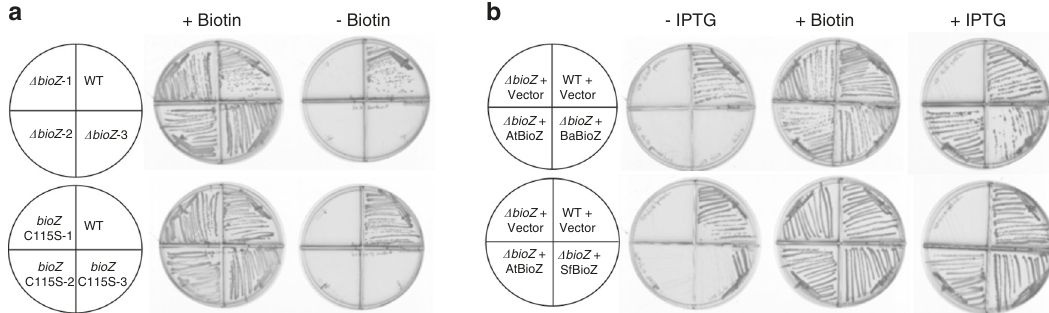
Fig. 4 Deletion of A. tumefaciens bioZ or introduction of the BioZ C115S mutation resulted in biotin auxotrophy that was restored by expression of diverse BioZ proteins. a Three Δ bioZ strains or three bioZ C115S strains were streaked on minimal medium plates that either contained or lacked biotin. b Complementation of a A. tumefaciens Δ bioZ strain by plasmids expressing the BioZ proteins of A. tumefaciens ( At) , B. abortus (Ba) or Sinorhizobium fredii (Sf). IPTG was added to induce